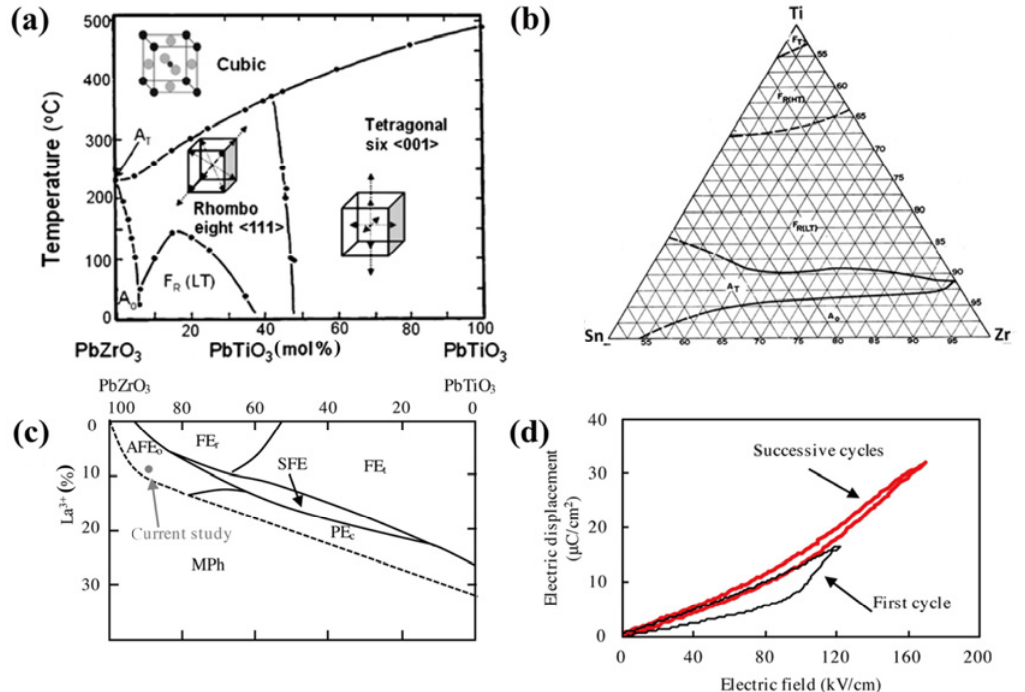
Fig. 5 Phase diagrams of (a) PZO–PbTiO 3 and (b) (Pb 0.97 La 0.02 )(Zr,Sn,Ti)O 3 . (c) Phase diagram and (d) energy storage performance of (Pb 0.88 La 0.08 )(Zr 0.91 Ti 0.09 )O 3 (PLZT). Reproduced with permission from Ref. [86] for (a), © Springer Nature 2007; Ref. [82] for (b), © WILEY-VCH Verlag GmbH & Co. KGaA, Weinheim 2018; Ref. [81] for (c, d), © AIP Publishing LLC